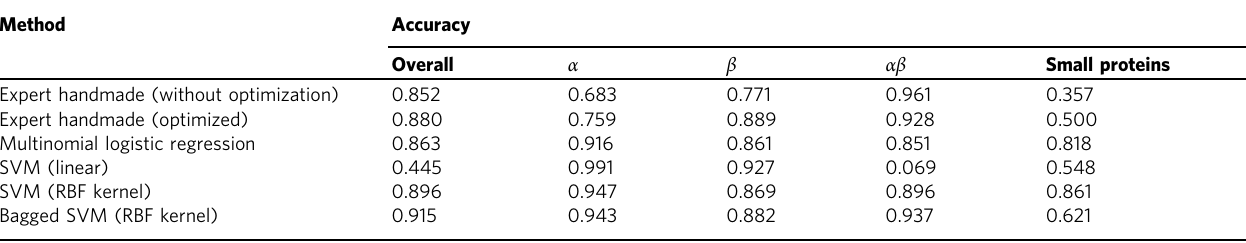
Table 3 Accuracy of fold class assignment on SCOPe.